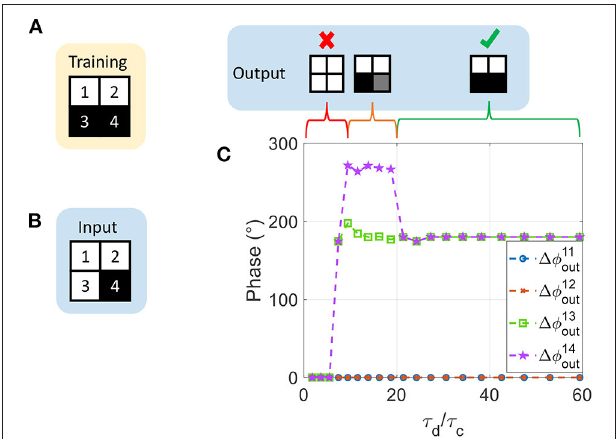
FIGURE 9 | (A) Training pattern stored by the ONN. (B) ONN input pattern. (C) Output phase with respect to τ d /τ c . For τ d /τ c < 7, all oscillators converge to a wrong in-phase relationship. For 7 ≤ τ d /τ c < 20, the fourth oscillator locks to a 270 ◦ phase state. A very asymmetrical waveform such that τ d /τ c ≥ 20 leads to a correct binary phase-locking.